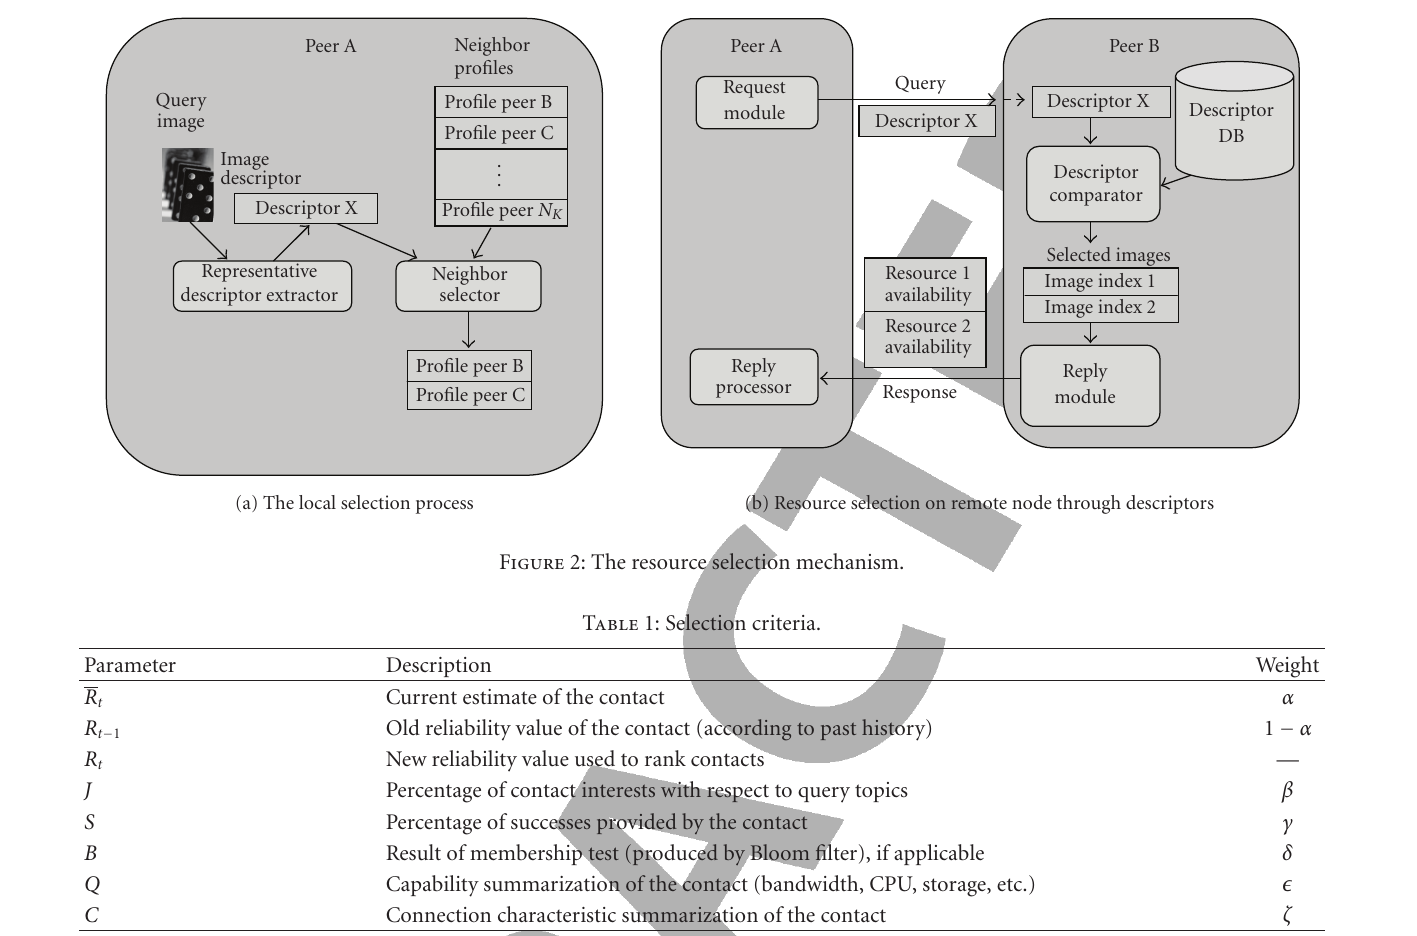
Figure 2: The resource selection mechanism. Table 1: Selection